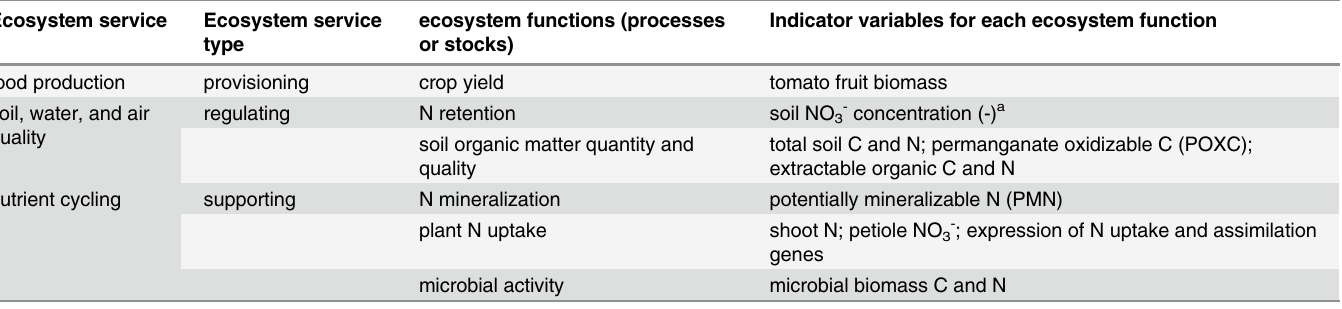
Table 5. Ecosystem functions representing ecosystem services, indicators of processes or stocks, and the indicator variables measured across 13 organic Roma-type tomato fields in Yolo Co., California, USA. Ecosystem